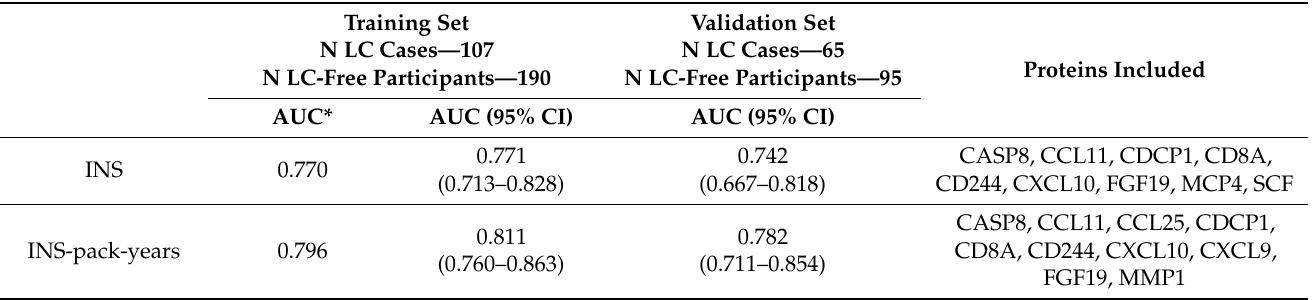
Table 2. Performances for predicting LC incidence during 17 years of follow-up in discovery and validation sets among ever smoking participants of the